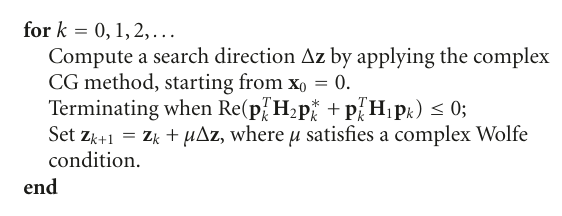
Algorithm 2: Complex line search Newton-CG